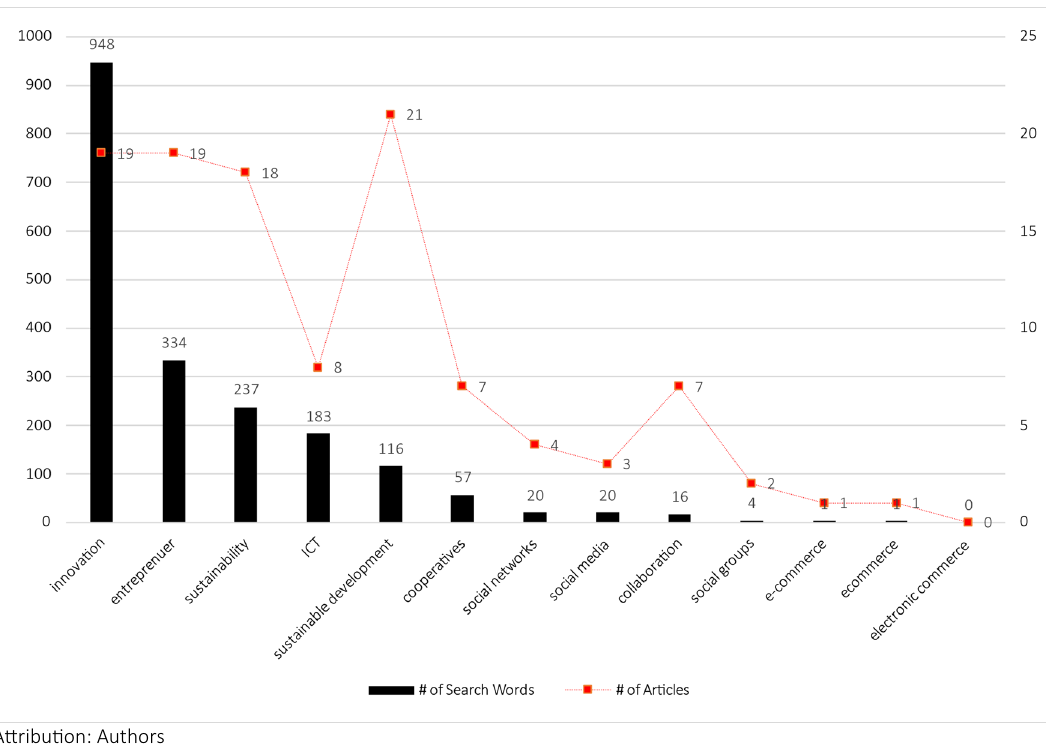
Fig. 3 Distribution of Search Words/Phrases in All Research